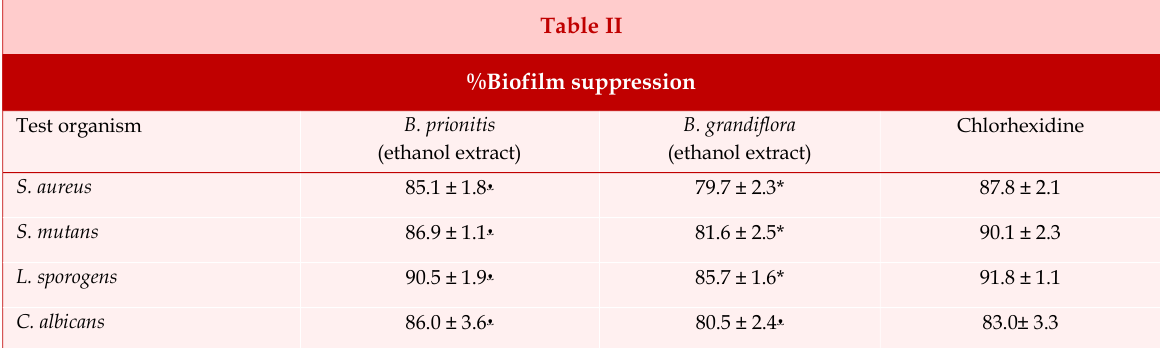
Antimicrobial activity of leaf